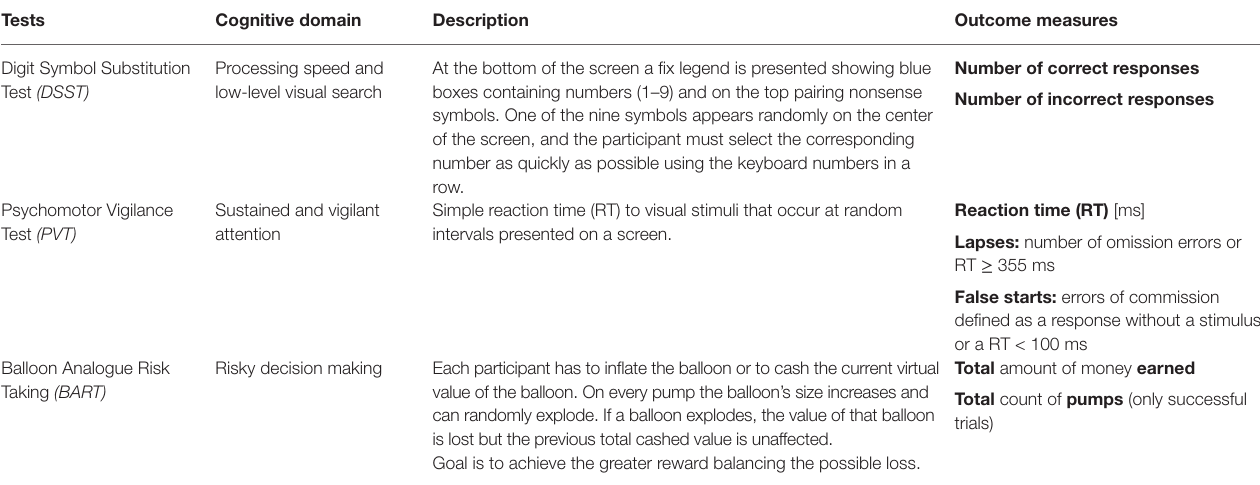
TABLE 1 | Description of the cognitive